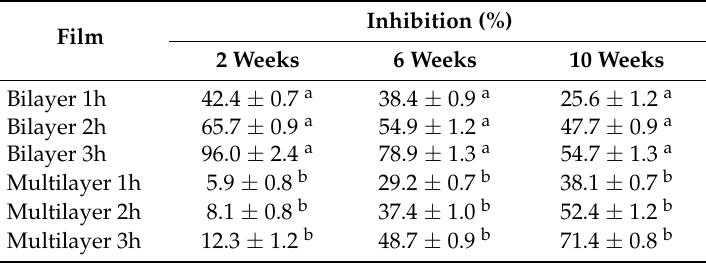
Table 4. Inhibition (%) of 2,2-diphenyl-1-picrylhydrazyl radical (DPPH) of the gallic acid (GA) released from the polylactide (PLA)